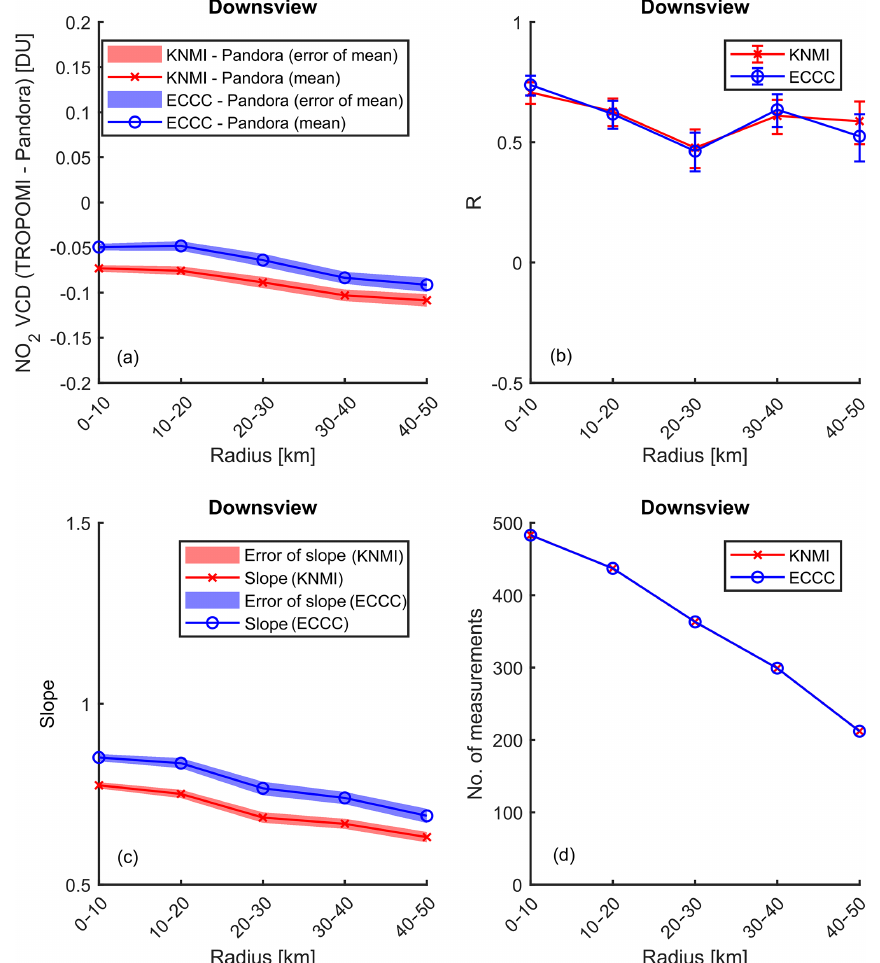
Figure B1. Sensitivity test for Pandora no. 104 at Downsview. For data within each radius bin, (a) shows the mean difference between TROPOMI and Pandora NO 2 VCD total , (b) shows the correlation coefficients, (c) shows the slope (zero offset linear fit), and (d) shows the number of coincident measurements. KNMI data are shown in red and ECCC data are shown in blue. The (a) symmetric standard error of the mean and (c) error of the slope are shown by colour-coded envelopes, indicated by the legends. The asymmetric error of the correlation coefficients is shown by error bars in (b) and (d)